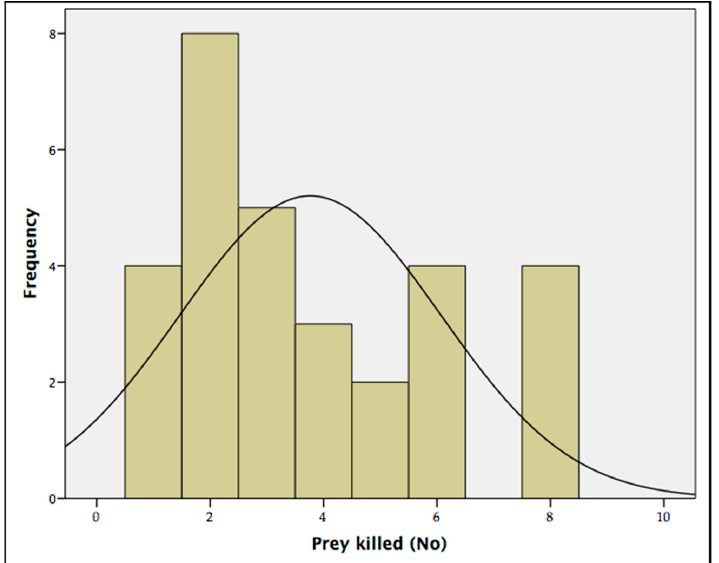
Figure 6. Mode of the predation rate of the predator larvae Aeolothrips intermedius on onion pest Thrips tabaci adults. The histogram represents the frequencies of Thrips tabaci preyed over 12 h. The curve represents a standard normal distribution.